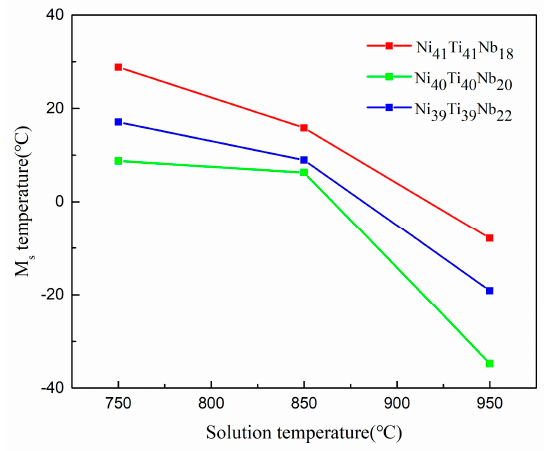
Figure 5. Relationship between Ms and solution temperature of NiTiNb hypoeutectic, eutectic, and hypereutectic alloys.